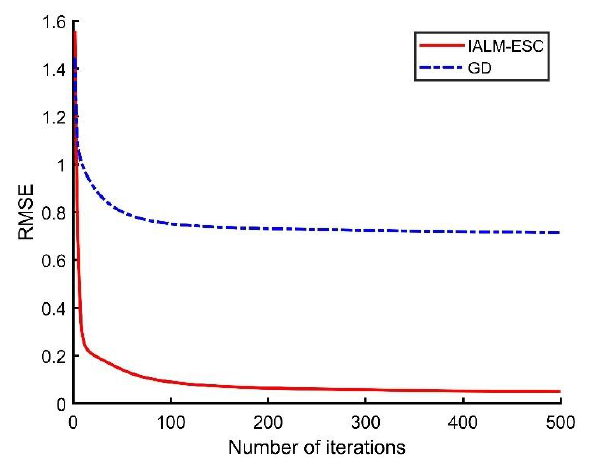
Figure 5. Convergence graph of RBFNN parameter learning training based on IAMM-ESC and GD.